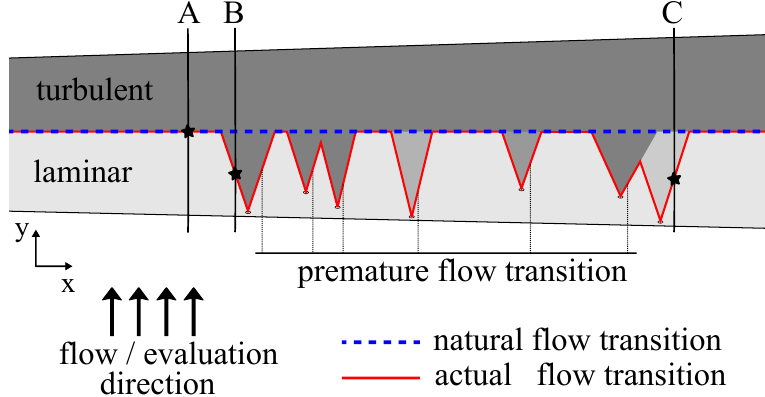
Figure 1. Sketch of a rotor blade with a turbulent (dark) and laminar (bright) flow regime. Multiple local surface disturbances trigger premature flow transitions resulting in turbulence wedges within the laminar flow regime. Blue dashed line: Natural flow transition line if no surface disturbances would exist. Red solid line: Actual flow transition line including premature flow transitions. Three evaluation line examples are given for no premature flow transition ( A ), a premature flow transition at a strong turbulence wedge ( B ), and a premature flow transition at a soft turbulence wedge ( C ). The respective temperature profiles and gradients over y are shown in Figure